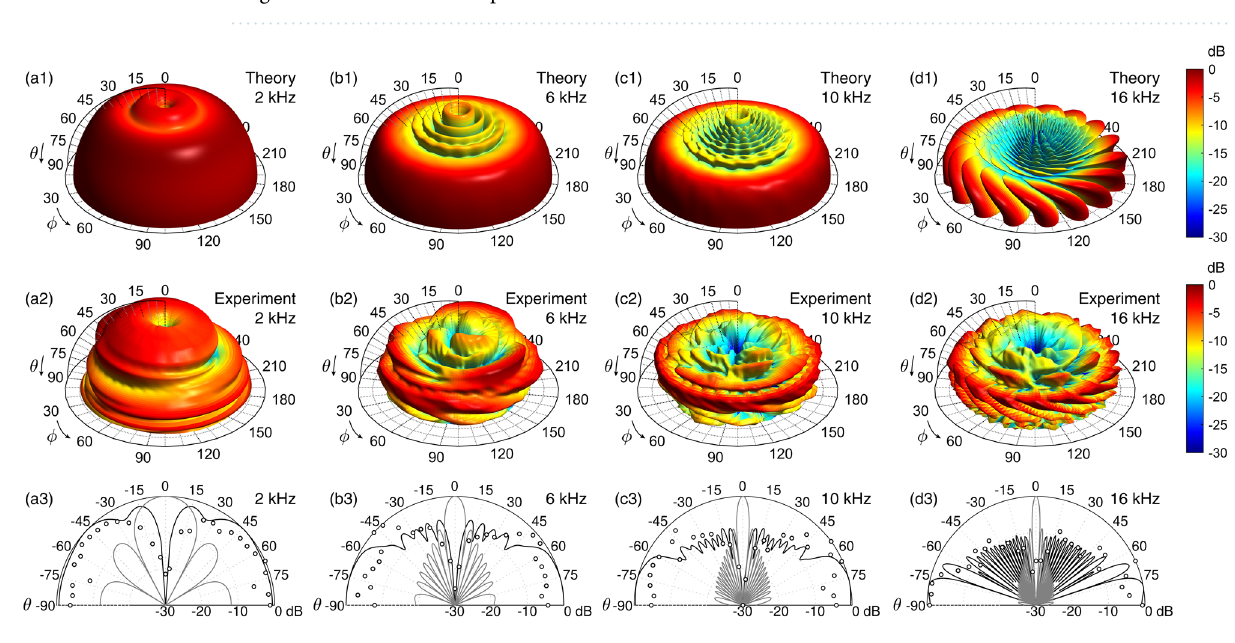
Figure 4. Scattering in the far field at 2 kHz obtained ( a1 ) theoretically and ( a2 ) experimentally. ( a3 ) Polar scattering at 2 kHz obtained experimentally (markers), theoretically (continuous line) and theoretical scattering of a flat panel of same dimensions. ( b1 – b3 ) Corresponding scattering in the near field at 6 kHz, ( c1 – c3 ) at 10 kHz and ( d1 – d3 ) at 16